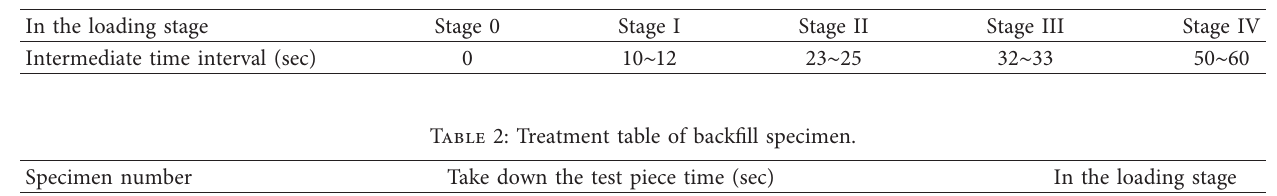
Figure 2: Stress-time curve of backfill under uniaxial compression. Table 1: Intermediate schedule of backfill loading stage.